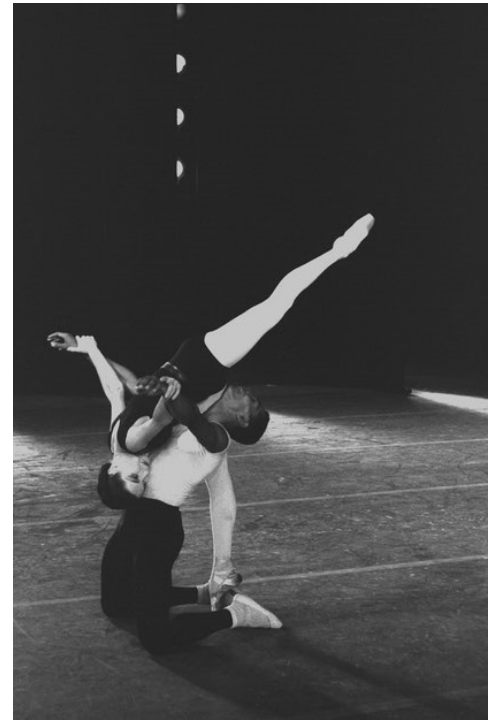
Figure 3. Agon duet in original casting with Diana Adams and Arthur Mitchell, 1963. Photo © Martha Swope and New York Public Library, used with permission.